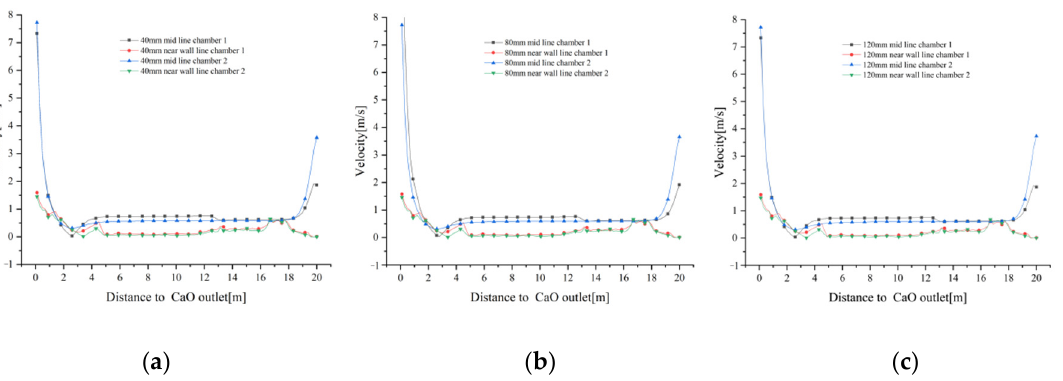
Figure 4. Gas velocity variation on the mid lines and near wall lines for 40 mm, 80 mm and 120 mm particle sizes. ( a ) Gas velocity variation at 40 mm; ( b ) Gas velocity variation at 80 mm; ( c ) Gas velocity variation at 120 mm.